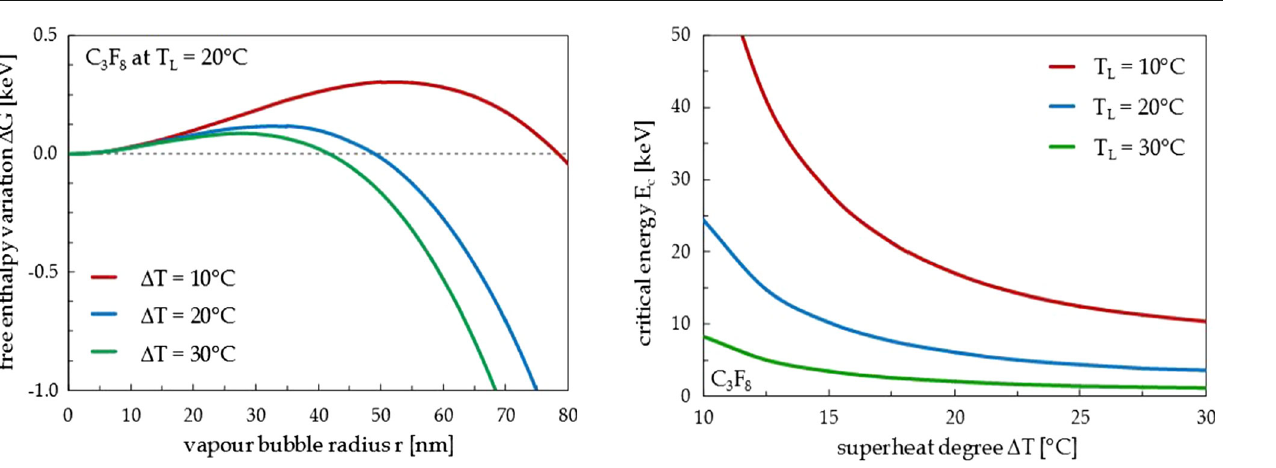
Fig. 3 Distributions of (cid:4) G ( r ) vs. r for C 3 F 8 at T L = 20 ◦ C, using (cid:4) T as a parameter